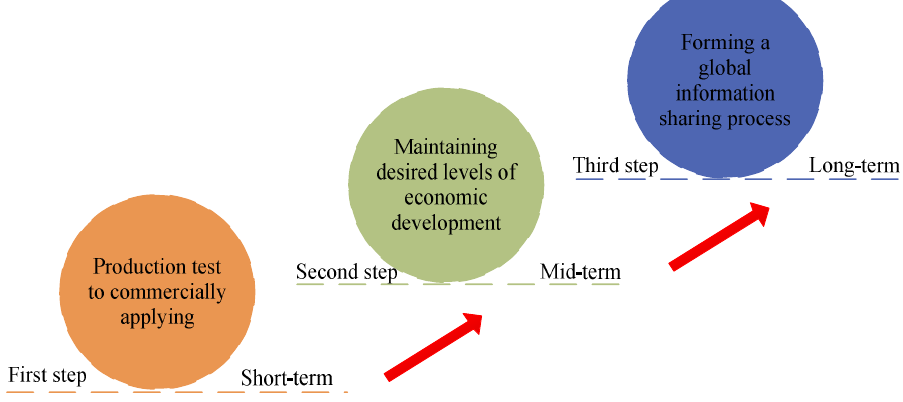
Figure 15. The “three-step” strategy of development.